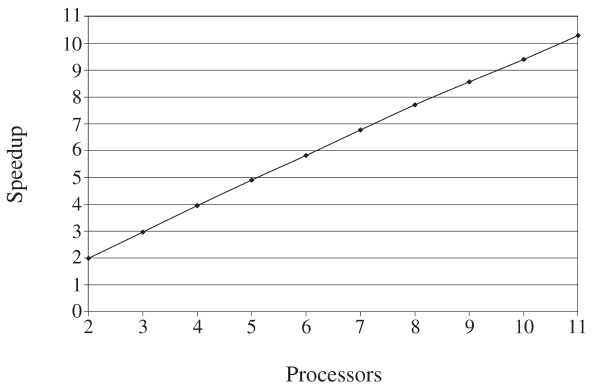
Figure 8 - Speedup based in computation time + I/O for 50 genes as com- plete feature space and 6 genes as small feature